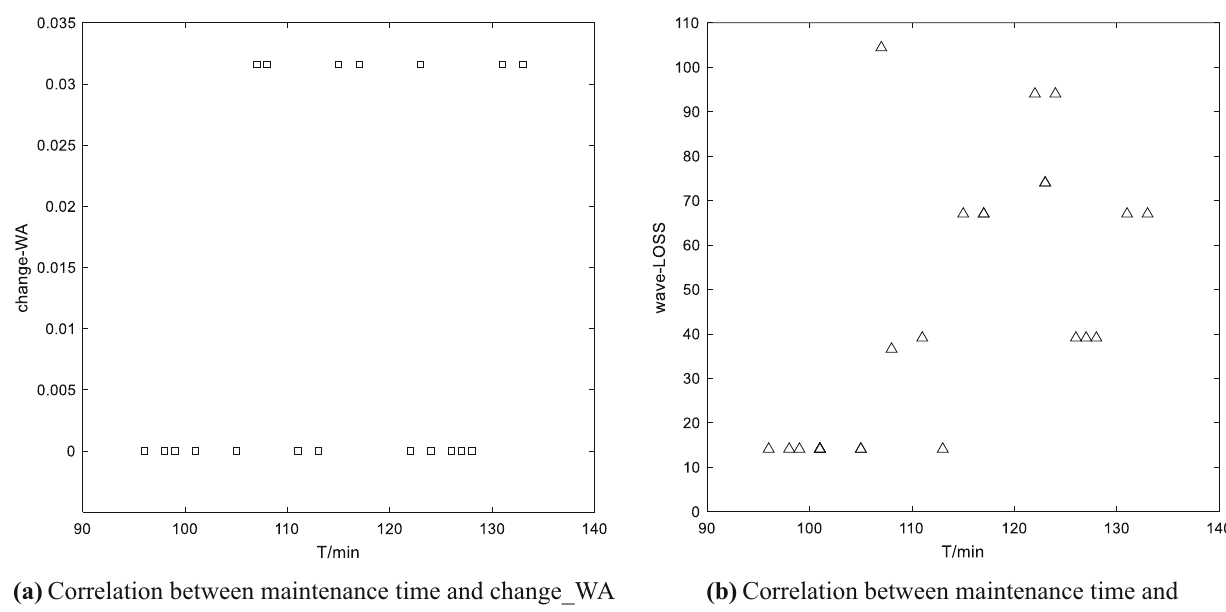
Fig. 19 Correlation between maintenance time and evaluation indexes for 10 carrier-based